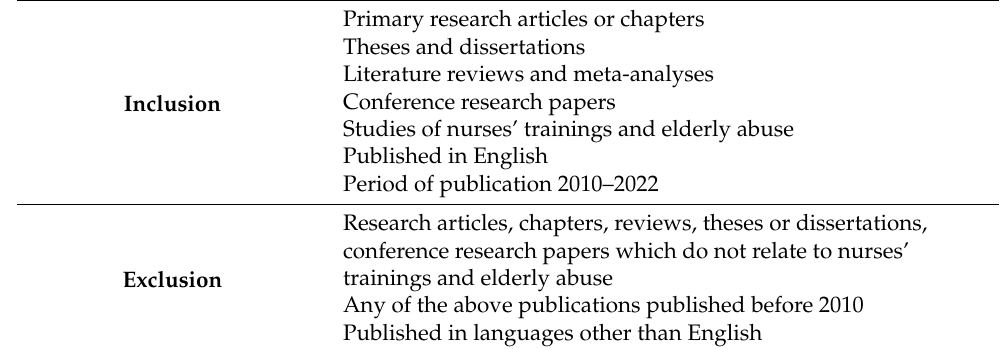
Table 1. Inclusion and exclusion